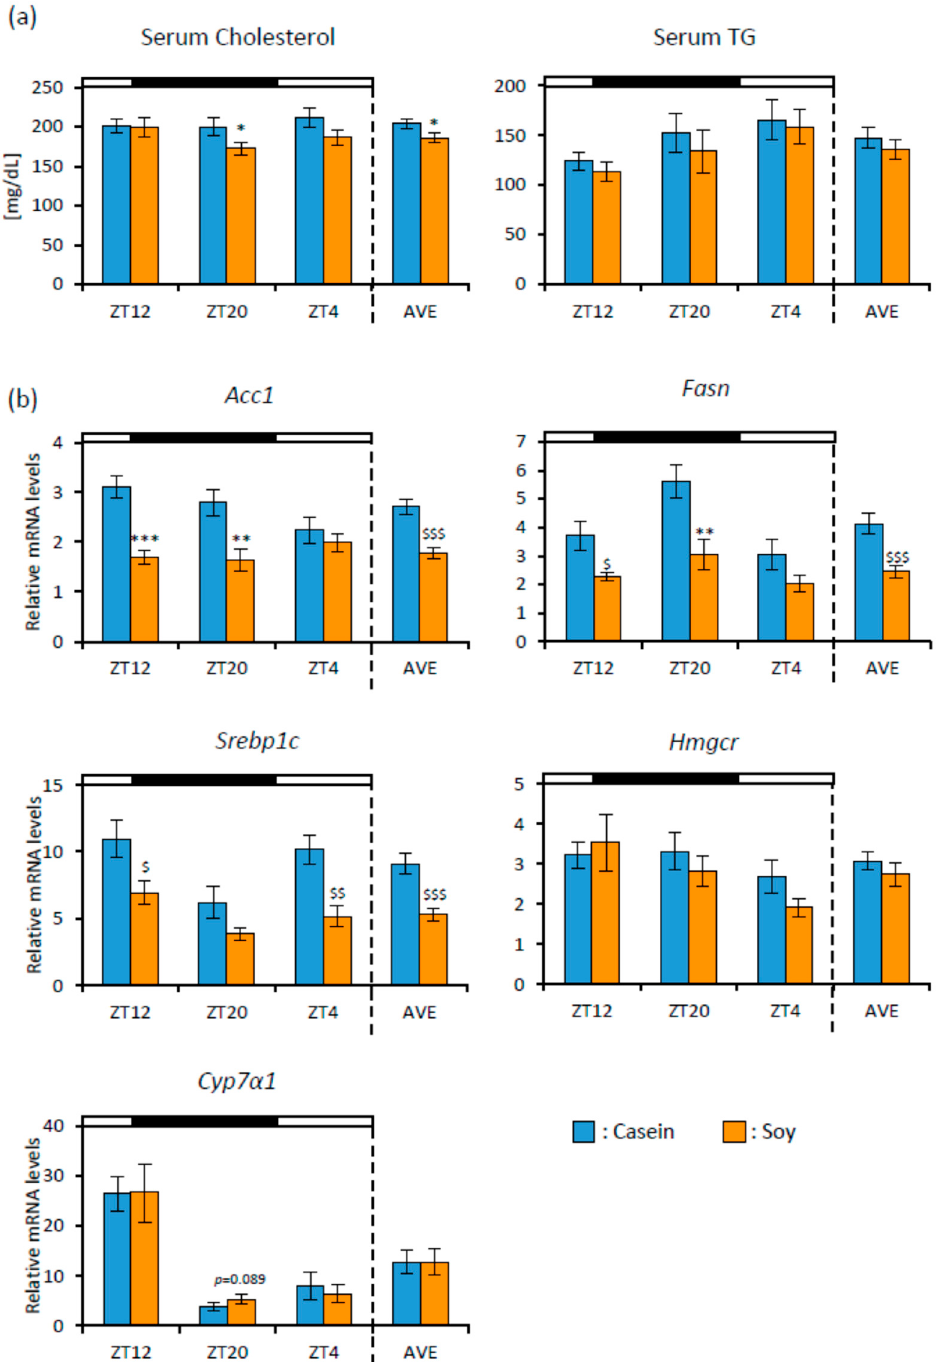
Figure 2. Serum lipid and gene expression levels in the liver. ( a ) Serum cholesterol and triglyceride levels (ZT12, ZT20, ZT4, and an average of three points) of mice that were fed each diet for 10 days. ( b ) Relative RNA expression levels of fatty acid and cholesterol metabolism-related genes in the liver (ZT12, ZT20, ZT4, and an average of three points) of mice that were fed each diet for 10 days. Data are represented as mean ± SEM ( n = 10). * p < 0.05, ** p < 0.01, *** p < 0.001 versus Casein, evaluated using Student’s t -test. $ p < 0.05, $$ p < 0.01, $$$ p < 0.001 versus Casein, evaluated using the Mann-Whitney test. High-fat diet, casein diet feeding, soy protein diet feeding, an average value of three points: HFD, Casein, Soy, AVE, respectively.